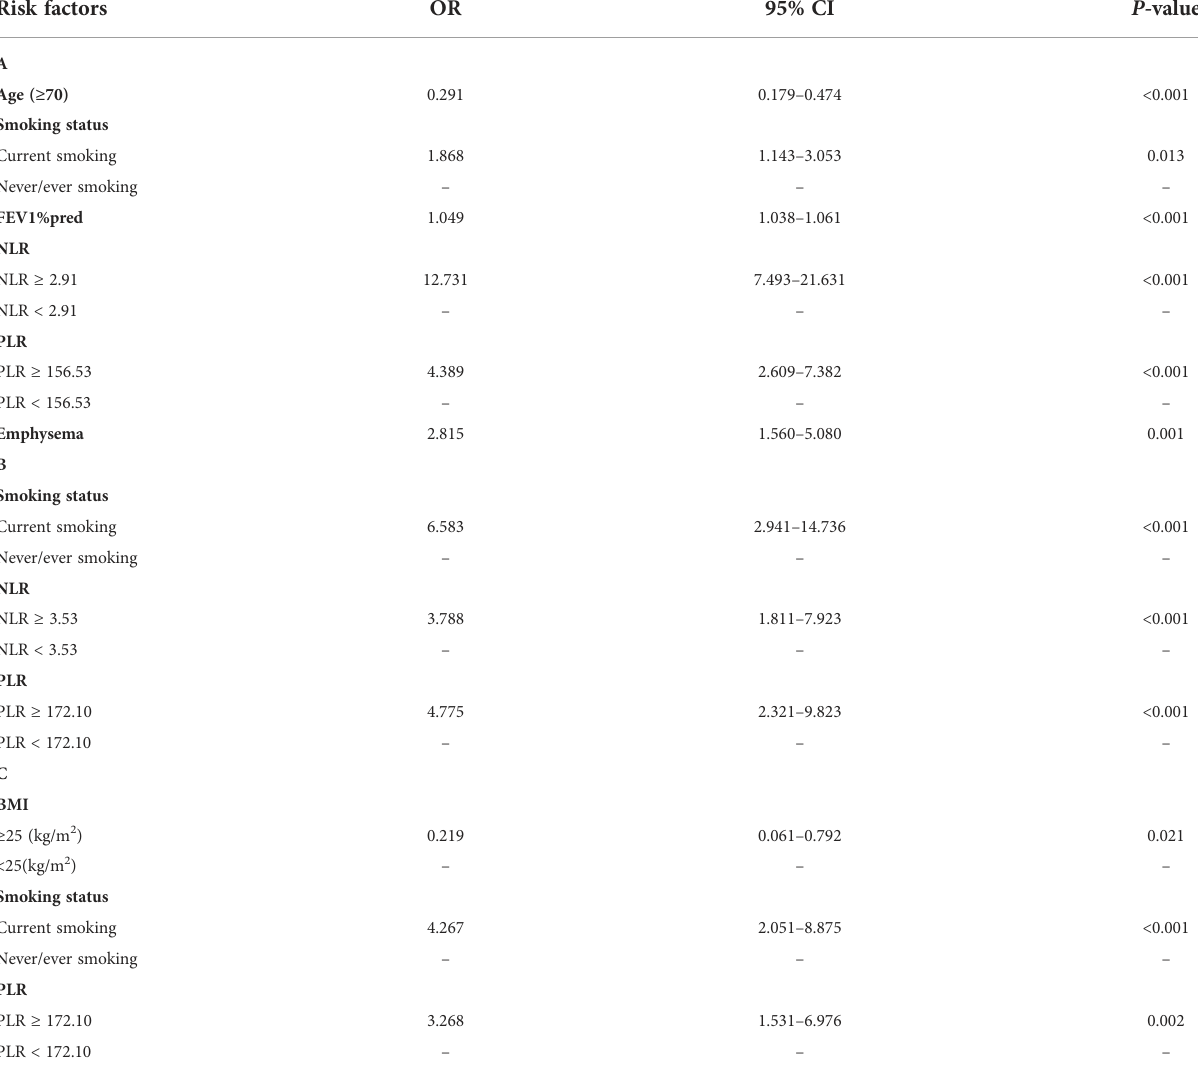
TABLE 2 Multivariate analysis of independent predictors of (A) lung cancer diagnosis in COPD patients, (B) TNM stages IIIB – IV at fi rst diagnosis in the COPD with lung cancer patients, and (C) ineligible surgery at fi rst diagnosis in the COPD with lung cancer patients. Risk factors